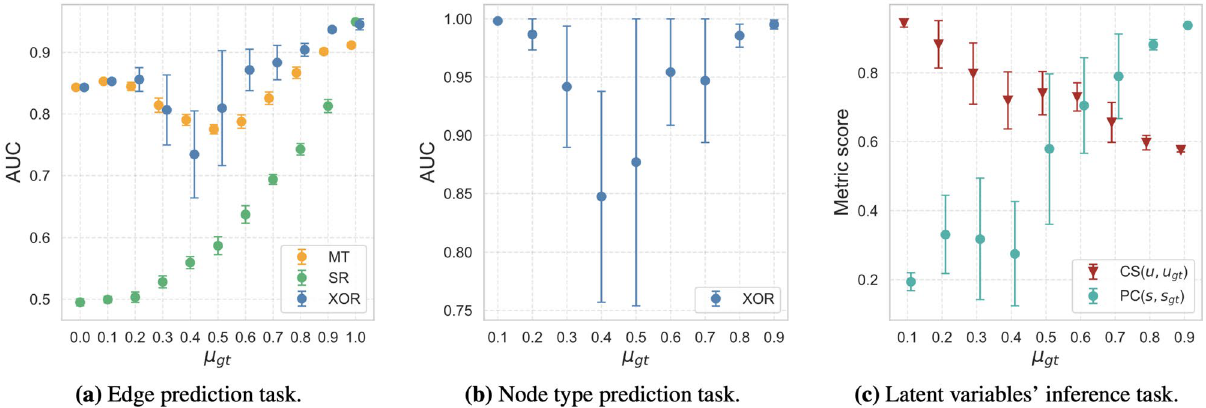
Figure 2. Performances on synthetic networks for different tasks. The mean value across folds is reported, indicating also the standard deviations. For the edge prediction task, our model is compared with the baseline methods MultiTensor and SpringRank. We vary the proportion of expected nodes with σ i = 1 , i.e. preferring a hierarchy-based interaction. Only the not regularised version of Xor is shown since it is the most effective in this